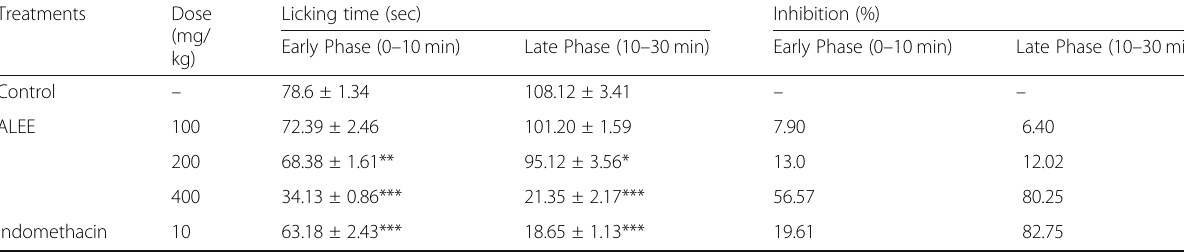
Table 2 Analgesic activity of ALEE on formalin-induced paw licking test rats